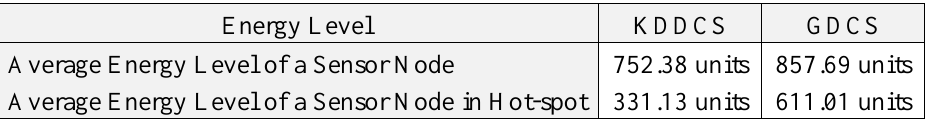
Table 2. Average energy level of each sensor node.